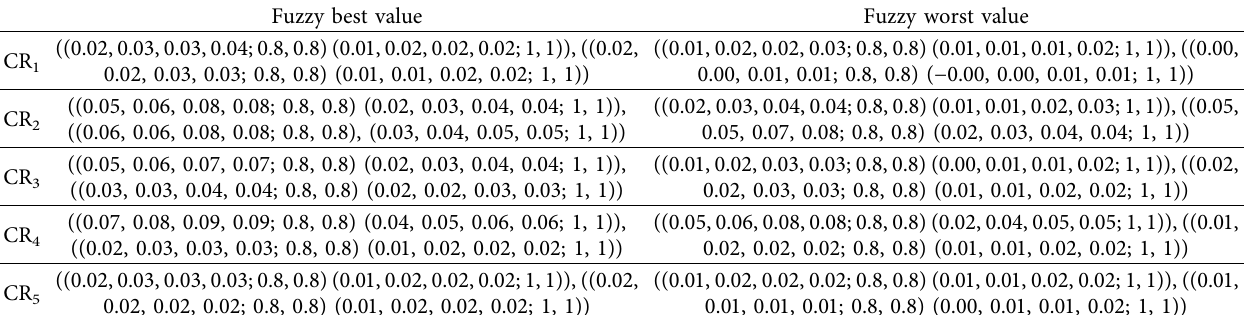
Table 10: Fuzzy best value and fuzzy worst value. Fuzzy best value Fuzzy worst